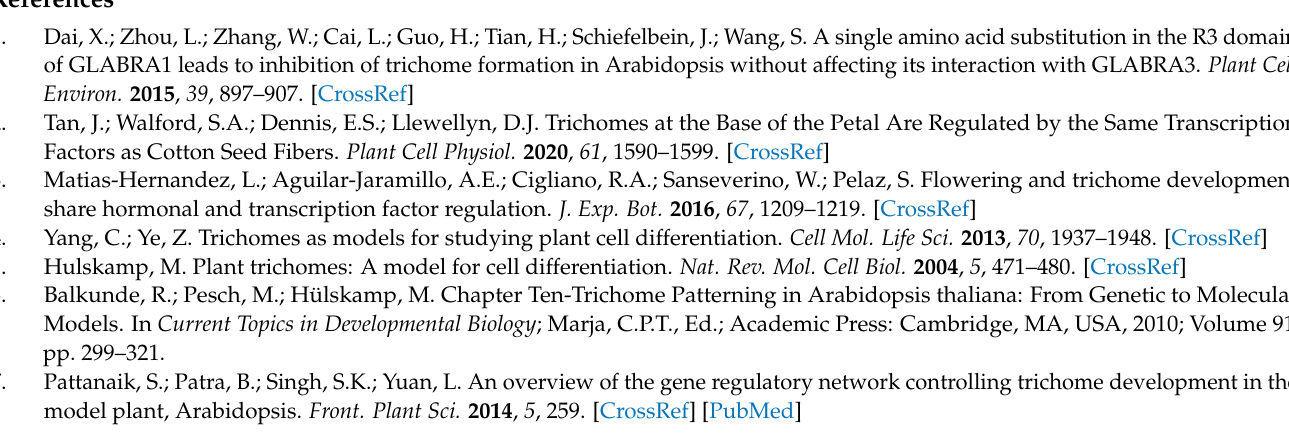
module; Figure S2: Diagram of interaction networks of genes in the MEmagenta module; Figure S3: Comparison of protein structures between GaFZ and RPB12, Table S1: Primers used in qRT-PCR, Table S2: Statistics and alignments of RNA-seq reads mapped to reference genome, Table S3: KEGG enrichment analysis of DEGs obtained from two accessions, Table S4: p -values of relationships between module and sample, Table S5: GO enrichment analysis of hub genes in the MEmagenta module, Table S6: Hub genes in the MEmagenta